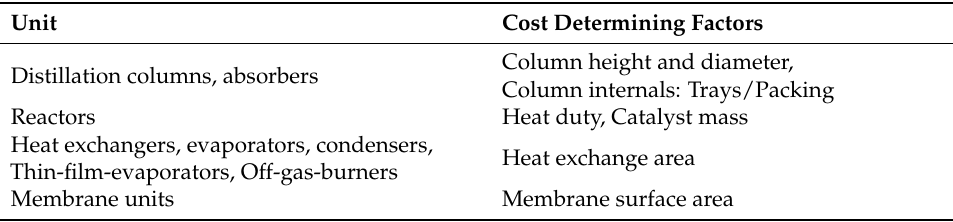
Table 1. Cost determining factors for each unit for the techno-economic analysis. Unit Cost Determining Factors Column height and Distillation columns, absorbers